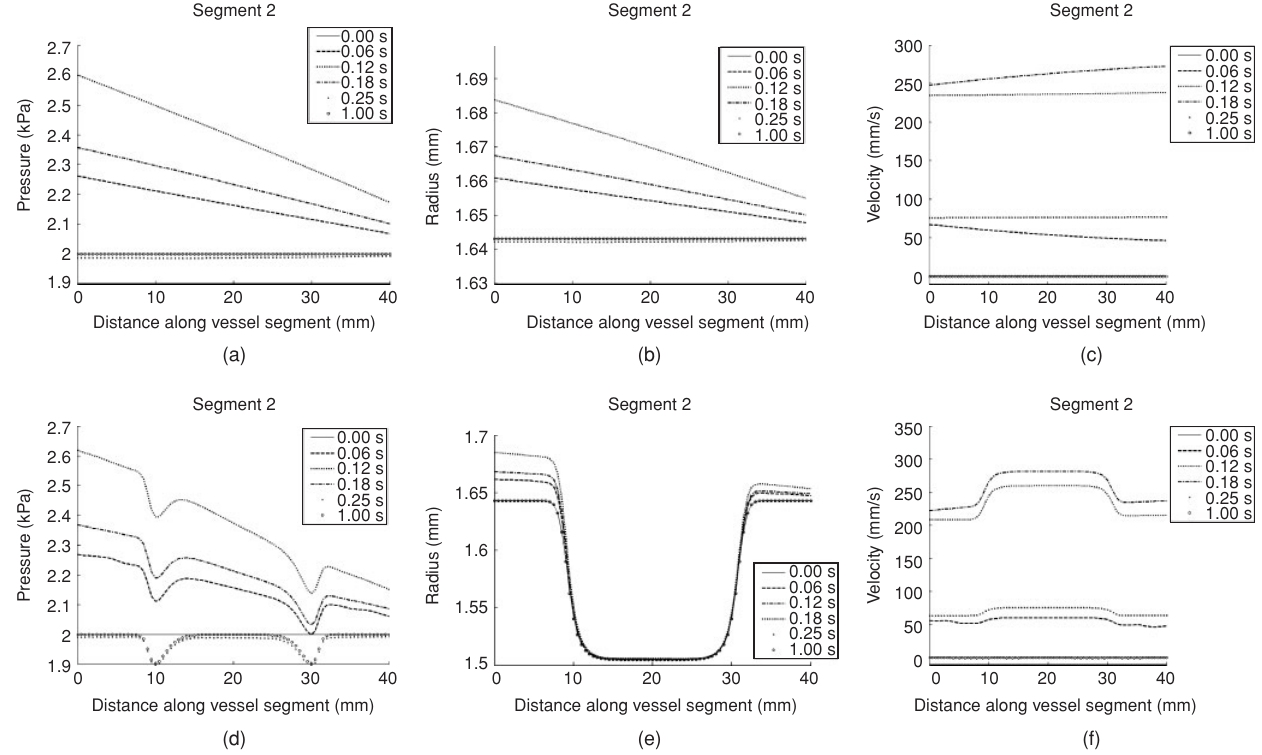
Figure 8 Pressure, radius and flow velocity along vessel segment 2 at the times shown in the legends of the plots in the unstented ((a)–(c)) and stented ((d)–(f)) cases. See Figure 1 for the positions of the vessel segment 2 in the network. 84